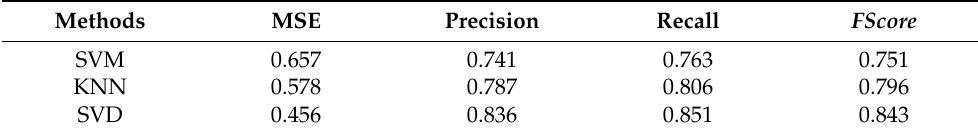
Table 2. Evaluation results of CF